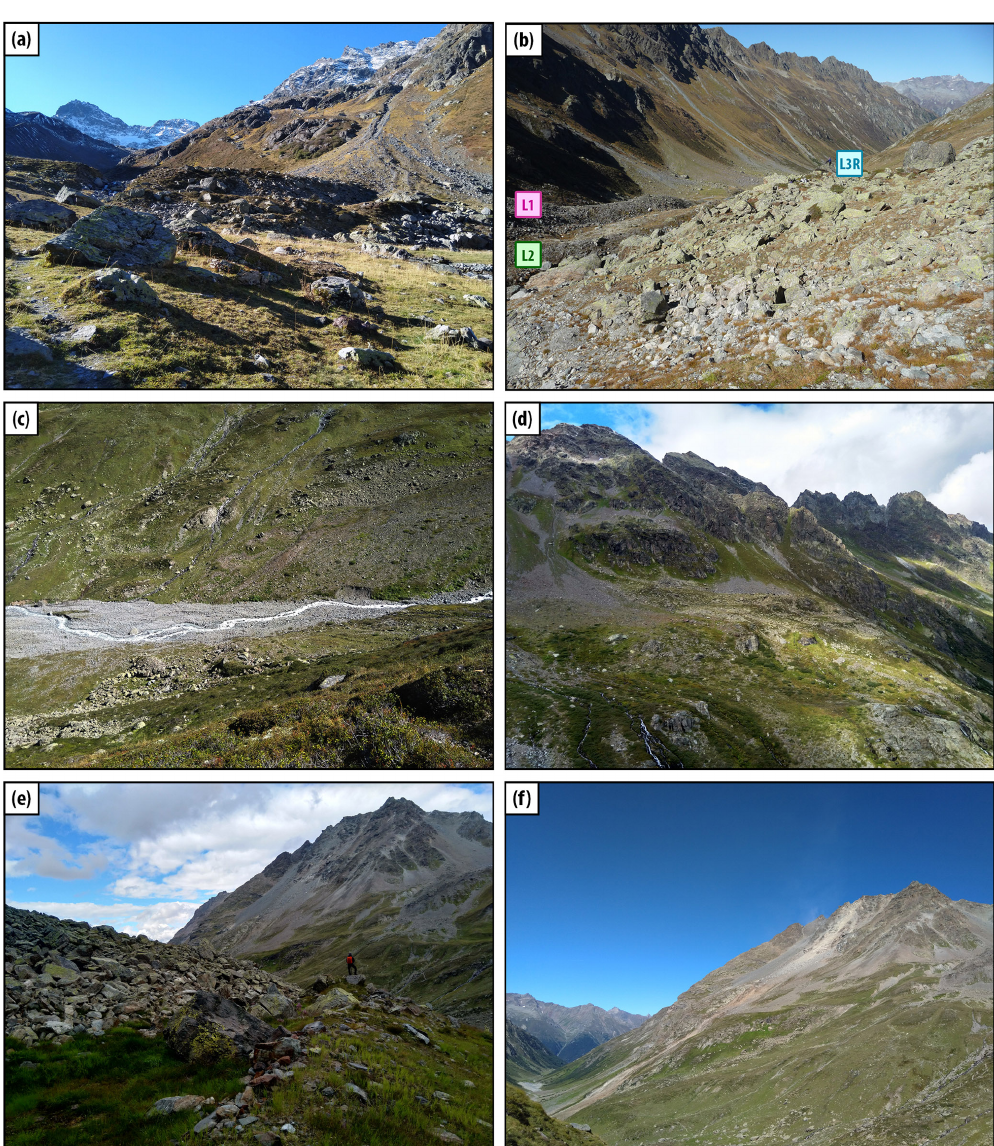
Figure A3. Laraintal. (a) Terminal moraines L3T and L4T dissected by a creek (Larainbach). (b) Right-lateral moraine set: L1, L2 (undated), and L3R. (c) Larainbach, with the modern river plane with L1 double-ridge structure identified on both sides of the creek. (d) Left-lateral flatter valley section, where moraines L3L and L1 and presumably Late Glacial moraines accumulated. (e) Left-lateral glacier side. Person standing on L1 ridge with L3L to the left. Hoher Kogel peak is in the background. (f) Provenance area of the rockfall event in 2019 near Hoher Kogel